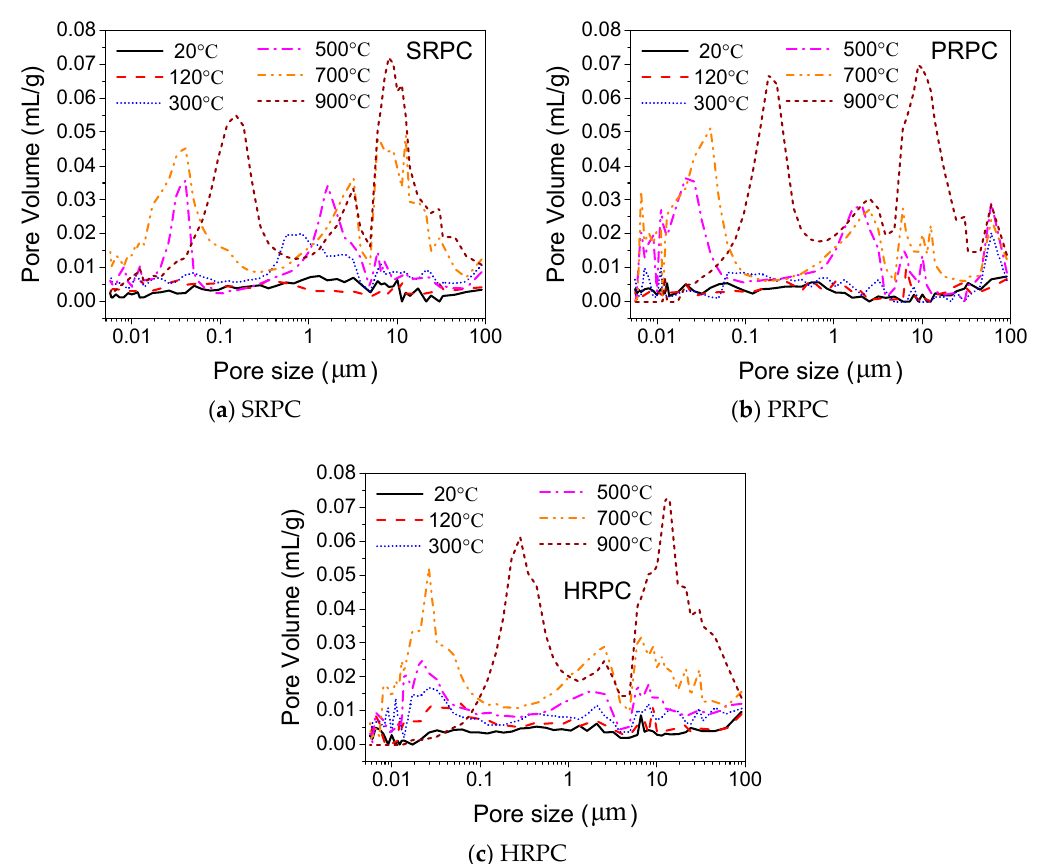
Figure 14. Changes of pore size distribution at high temperature ( a ) steel fiber reinforced RPC (SRPC), ( b ) polypropylene fiber reinforced RPC (PRPC), and ( c ) hybrid fiber reinforced RPC (HRPC).